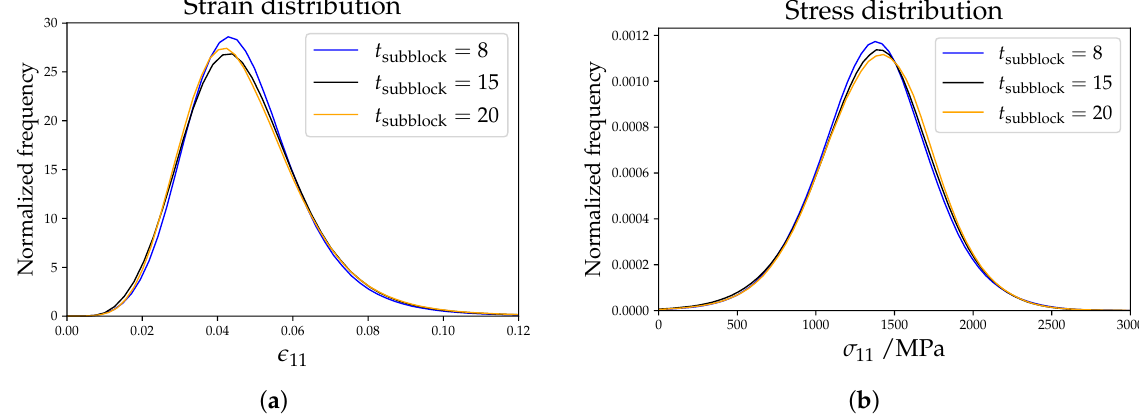
Figure 12. Distributions of strain ( a ) and stress ( b ) in the rolling direction for different subblock